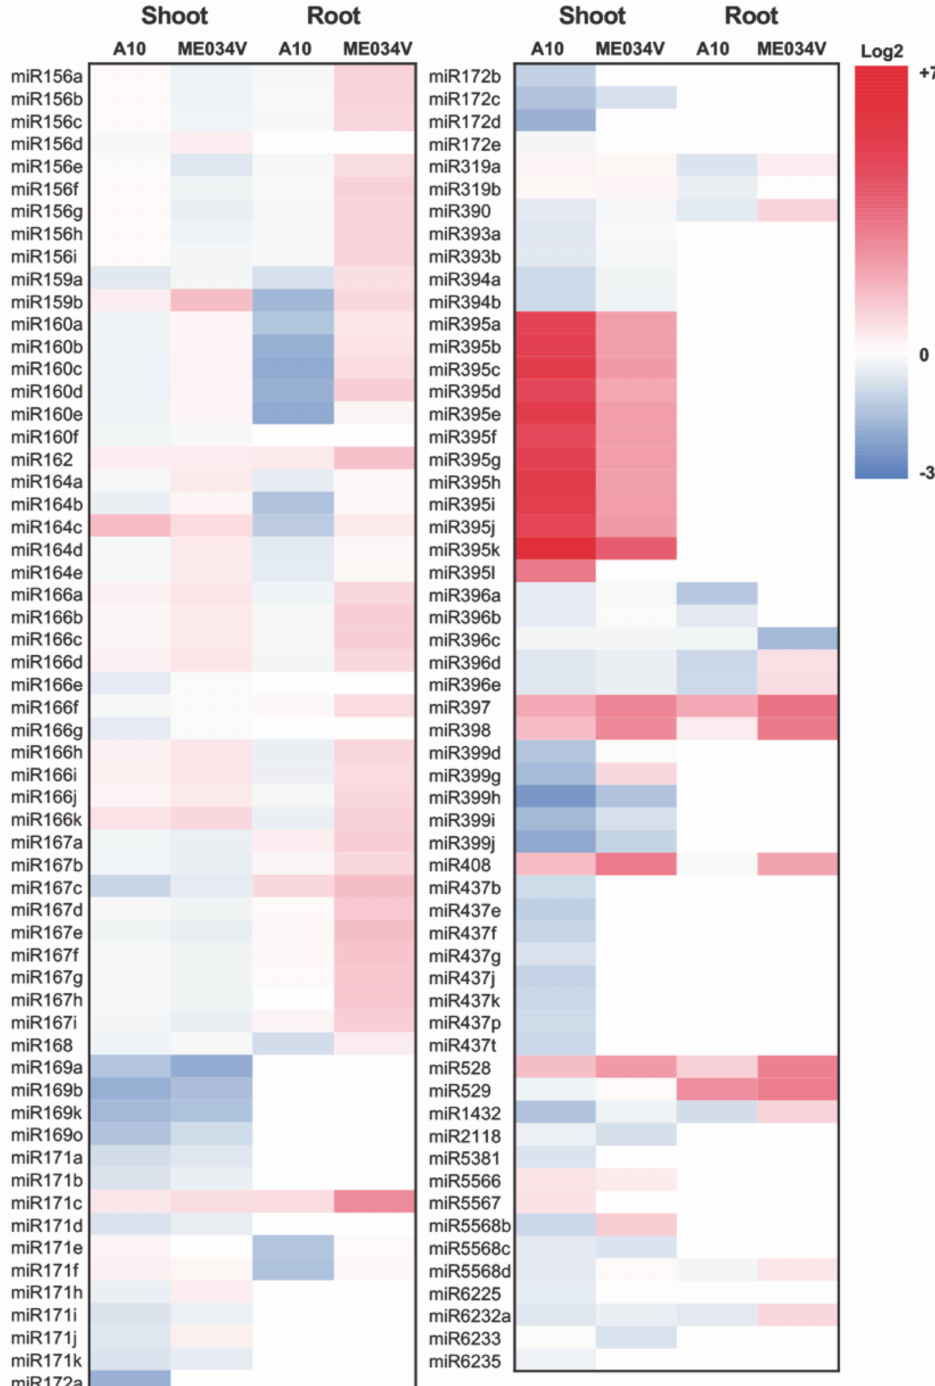
Figure 2. Profiling of the salt stress responsive microRNA landscape of the shoots and roots of 10-day-old A10 and ME034V seedlings. The four columns of the heat map depict the fold change in abundance for each miRNA detected in salt stressed A10 shoots, ME034V shoots, A10 roots and ME034V roots. Red colored tiles represent miRNAs with enhanced abundance post the 7-day salt stress treatment period while blue colored tiles depict miRNAs with reduced abundance post salt stress application. White colored tiles indicate that the miRNA failed to accumulate to detectable levels in the assessed